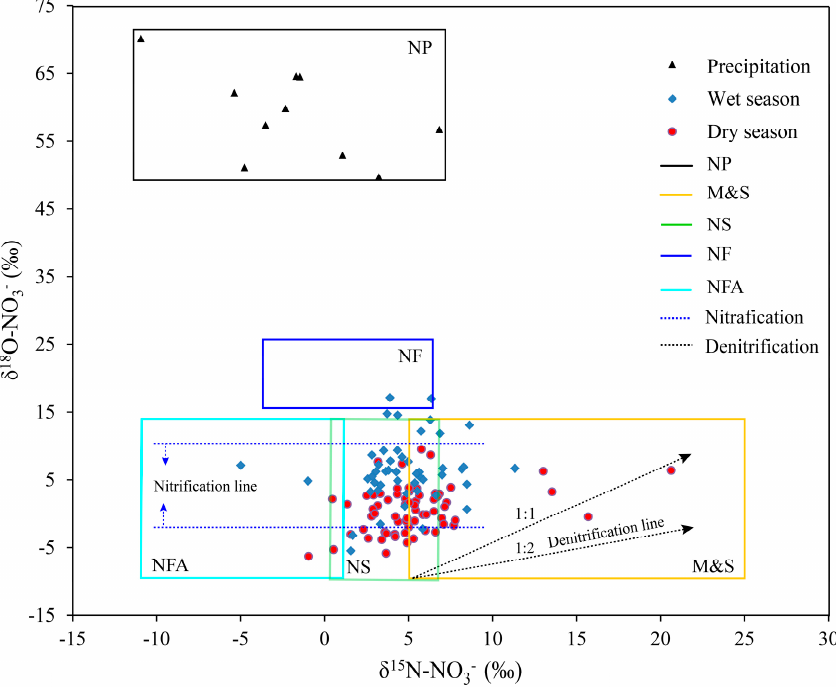
Figure 5. Range of δ 15 N and δ 18 O values for potential nitrate sources and in the Huashan watershed. NP means NO 3 − in precipitation; M & S for manure and sewage; NS for soil nitrogen; NF for NO 3 − fertilizer; and NFA for NO 3 − nitrified from NH 4 ⁺ in fertilizer and